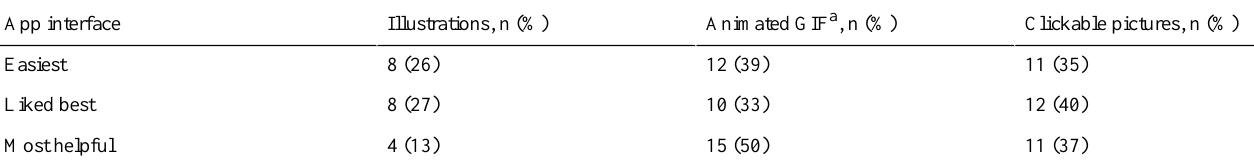
Table 5. Subjects' perception of different app embodiments. All values are given as n